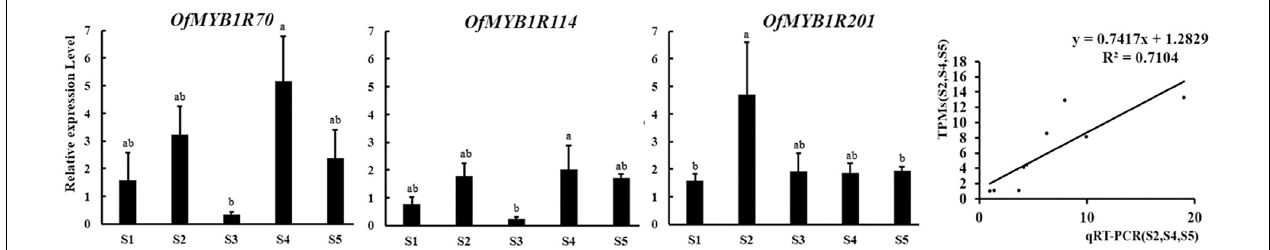
FIGURE 5 | Expression patterns of three candidate OfMYB-related genes using the average of three reference genes ( ACTIN , RAN , and RBP2 ) in different stages of sweet osmanthus flowers. Three biological and technological replicate measurements were performed for each stage, and the data are shown as the mean ± SD ( n = 3) at the top of each bar. The small letters above the error bars indicate significant differences obtained in SPSS 25 with Tukey’s test at P < 0.05. S1–S5 represent the bud-pedicel stage, bud-eye stage, primary blooming, full blooming, and flower fading stage, respectively, on the abscissa.